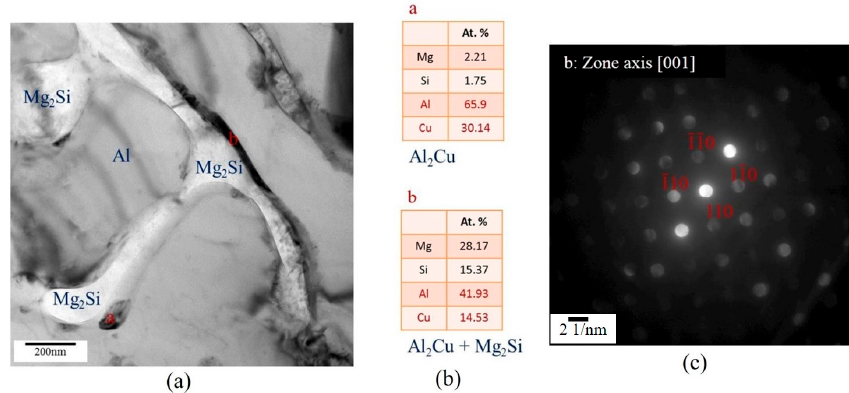
Figure 10. Analysis of Al 2 Cu in liquid pool. ( a ) morphology of globule boundary; ( b ) composition of phases analyzed by EDS; ( c ) diffraction pattern of phase b .